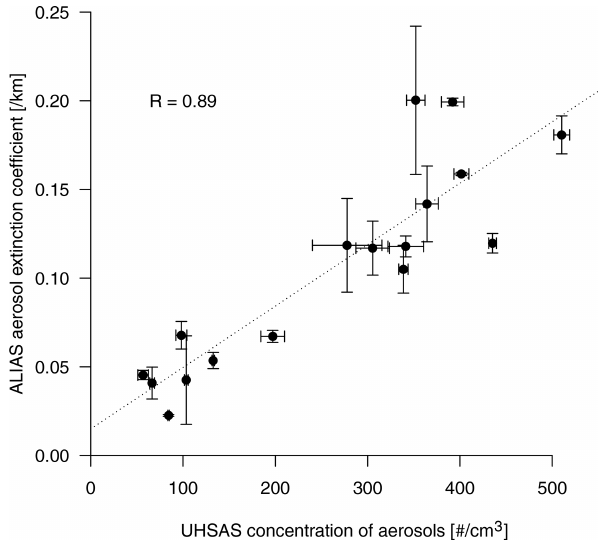
Figure 11. Relationship between the total concentration of aerosols measured by UHSAS at cloud base and the aerosol extinction coef- ficient measured by the horizontally pointing ALiAS lidar at cloud base. Horizontal and vertical bars represent the standard deviation of measurements across the different R patterns of each